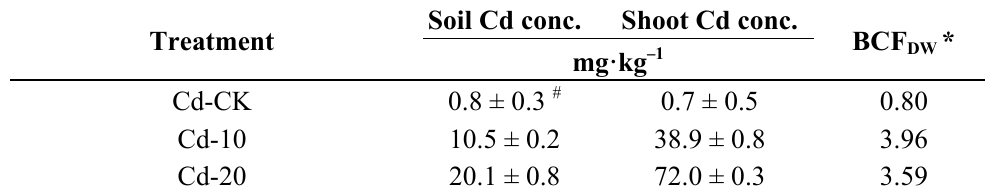
Table 1. The dry weight based bioconcentration factor (BCF Cd-contaminated soils for 50